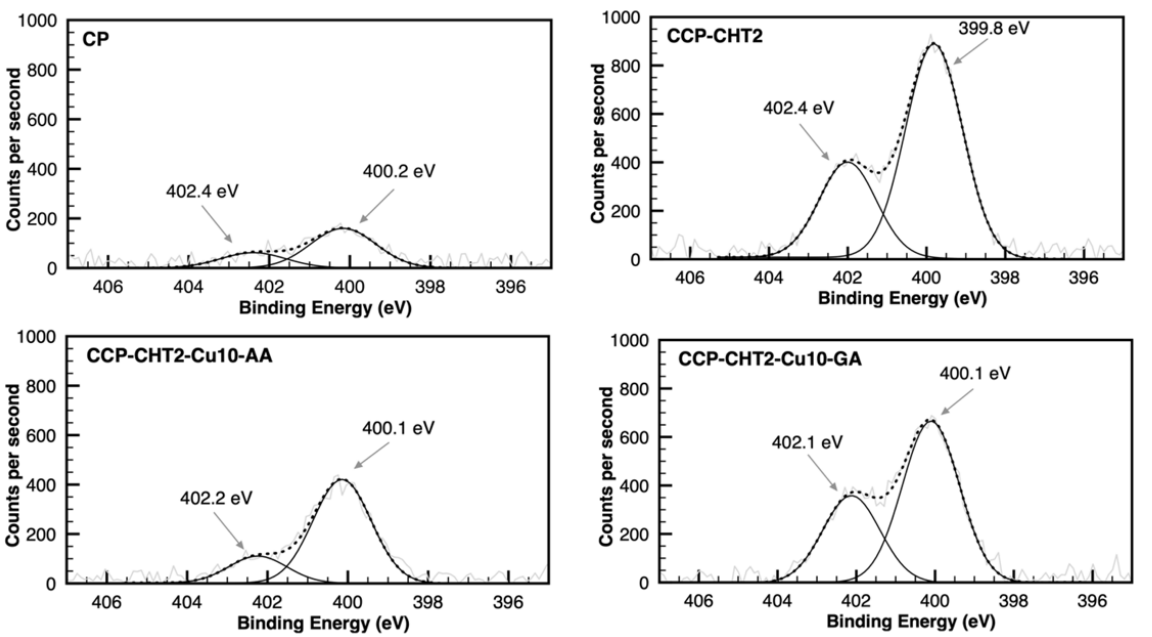
Figure 8. Gaussian deconvolution of high-resolution XPS N 1s spectra from CP, CCP-CHT2, CCP-CHT2-Cu10-AA, and CCP-CHT2-Cu10-GA samples. The Gaussian deconvolution of Cu 2p high-resolution XPS spectra indicated the coexistence of CuO and Cu 2 O in both CCP-CHT2-Cu10-AA and CCP-CHT2-Cu10-GA samples. An additional peak was observed in the CP-CHT2-Cu10-GA spectrum, which was ascribed to CuSO 4 salt (Figure 9 and Table 3). The Cu 2p3/2 region in the CCP-CHT2- Cu10-AA sample could be deconvoluted into two peaks at 933.2 eV and 934.9 eV. The Cu 2p1/2 region was also deconvoluted into two peaks at 952.4 eV and 954.2 eV. The peaks at 933.2 eV and 952.4 eV were assigned to the Cu + -ions of oxidized species, while the peaks at 934.9 eV and 954.2 eV indicated the Cu 2+ -ions of oxidized species [40,41]. Similarly,